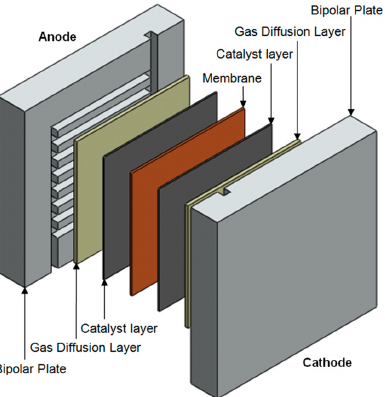
Figure 1. The layer structure of a proton exchange membrane fuel cell